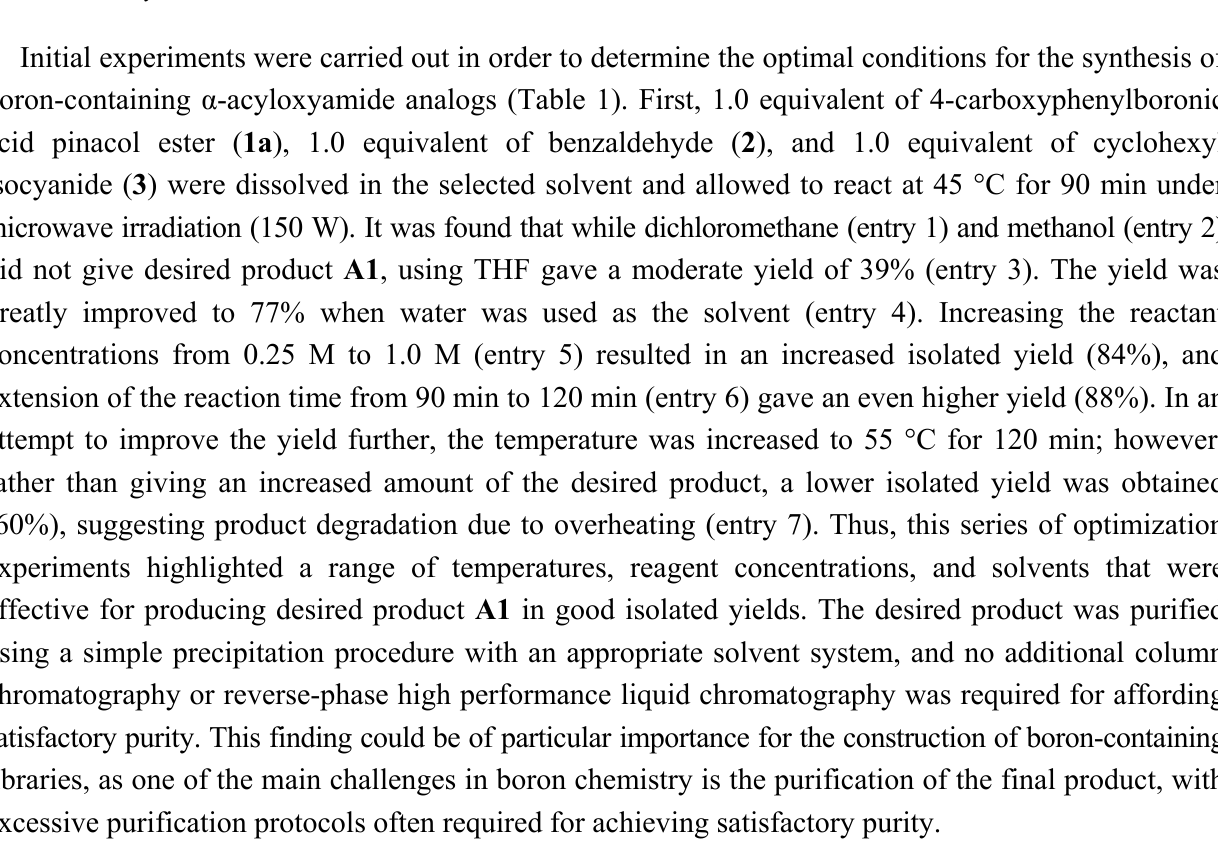
Table 1. Optimization of Passerini reaction using boron-containing acid building